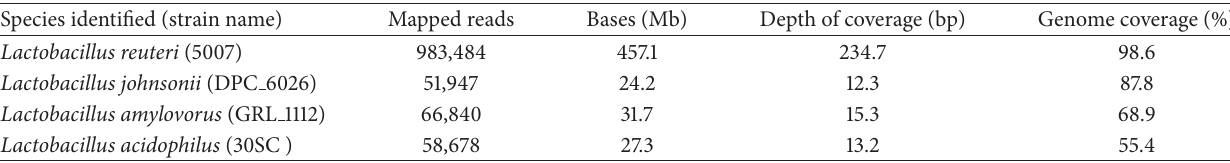
Table 2: Genome capture of Lactobacillus , the most dominant genus identified within the nonhuman model dataset. Reads were mapped against a reference genome of the most abundant strain within the respective species identified.